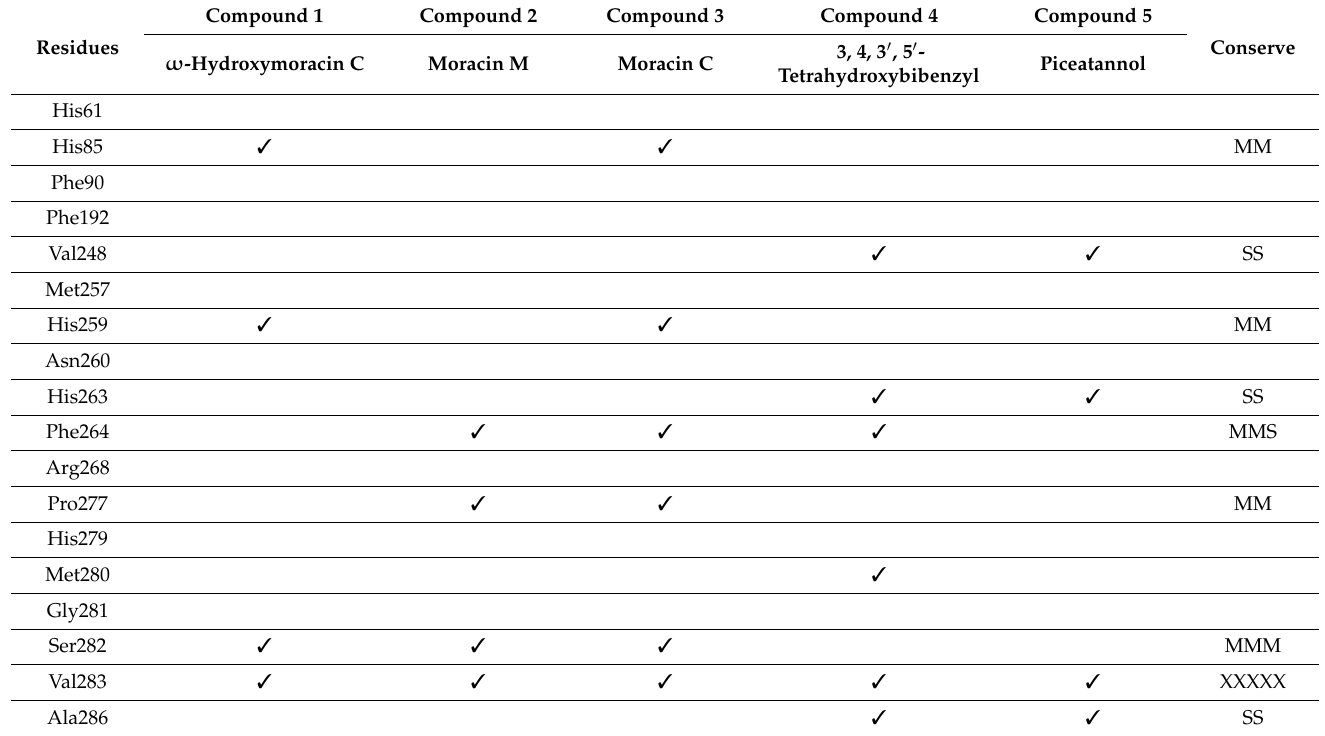
Table 3. Molecular interaction obtained from molecular docking of compounds 1 to 5 and conserved amino acids interacting with compounds of